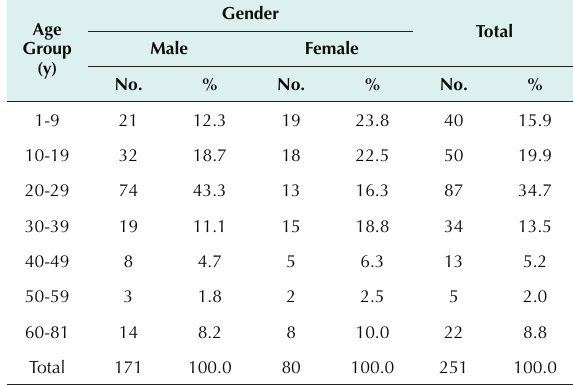
Table 1. Distribution of RTA Victims According to Age and Gender